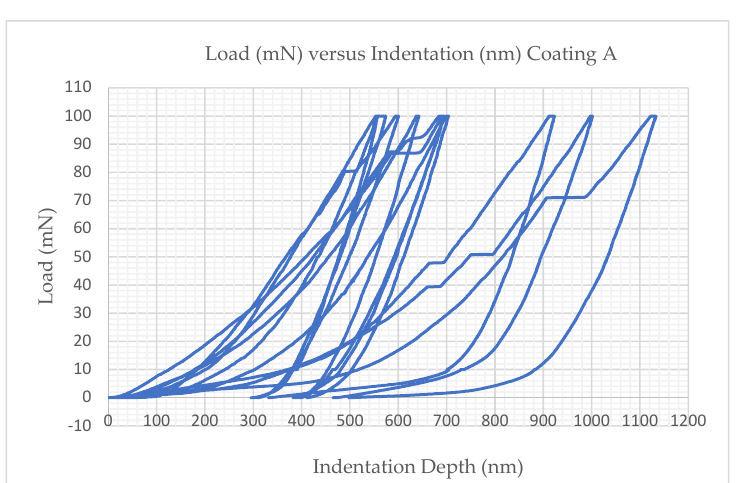
J. Manuf. Mater. Process. 2023 , 7 , x FOR PEER REVIEW Figure A1. Nanoindentation test results for Coating A. Figure A1. Nanoindentation test results for Coating A.